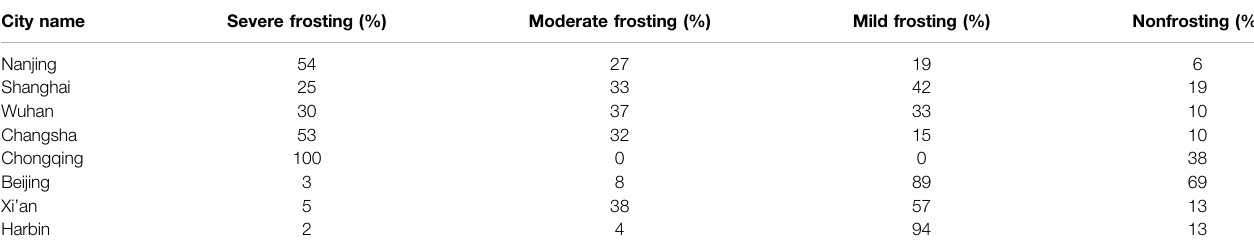
TABLE 2 | The proportion of frosting degree in typical